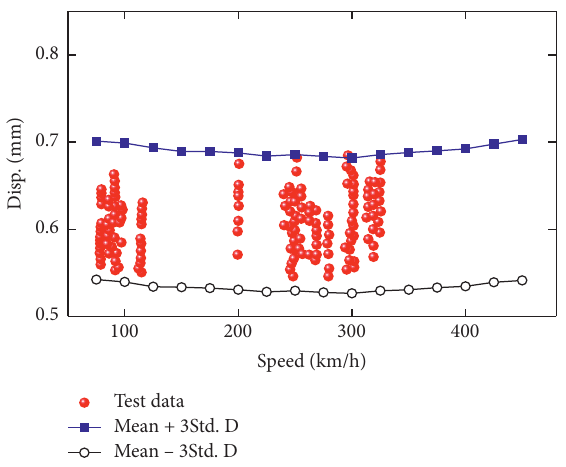
Figure 9: Calculation results and test